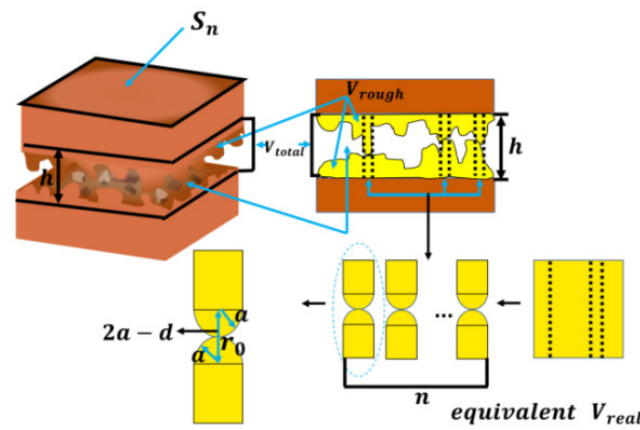
Figure 3. Schematic diagram of the contact volume and equivalent actual contact volume between rough surfaces [17].